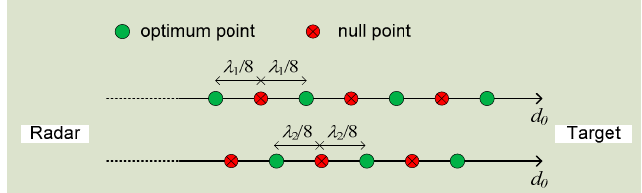
Figure 2. Frequency tuning using double sideband transmission to overcome the null point issue in